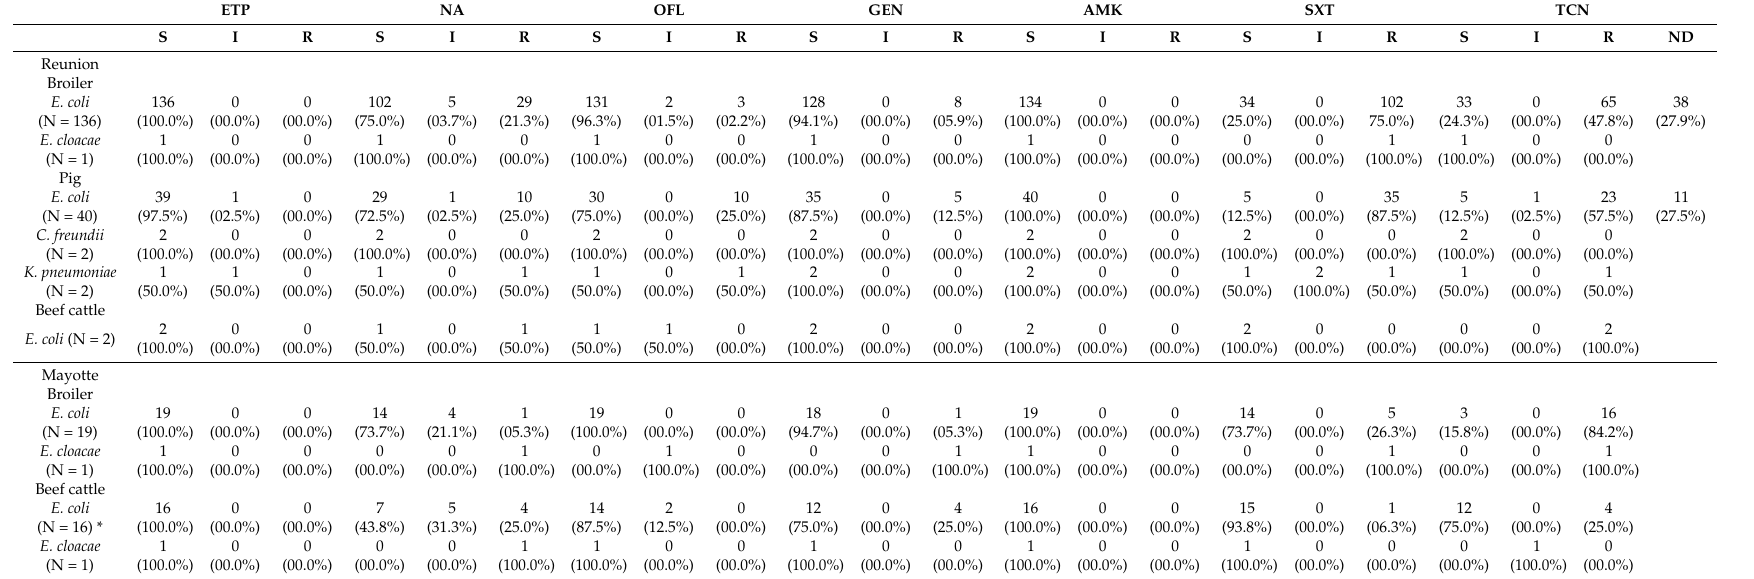
Table 3. Antibiogram results of ESBL-E from livestock production farms of Reunion, Mayotte and Madagascar, 2016–2017.